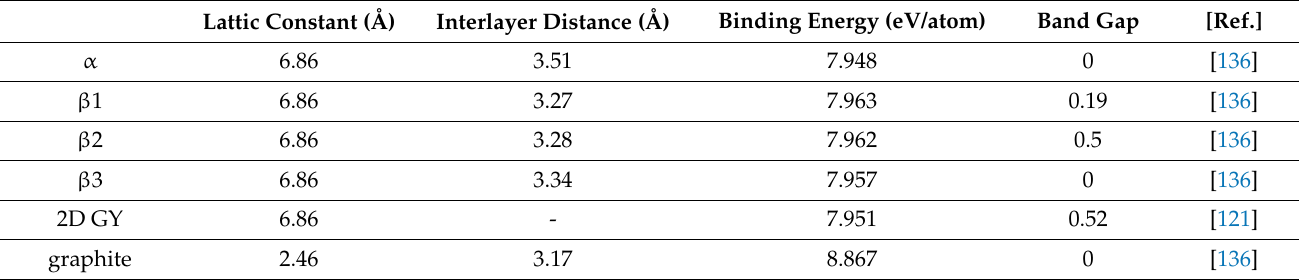
Table 3. Optimized lattice constant, interlayer distance, binding energies, and band gap for 2D and 3D graphyne and graphite a . Lattic Constant